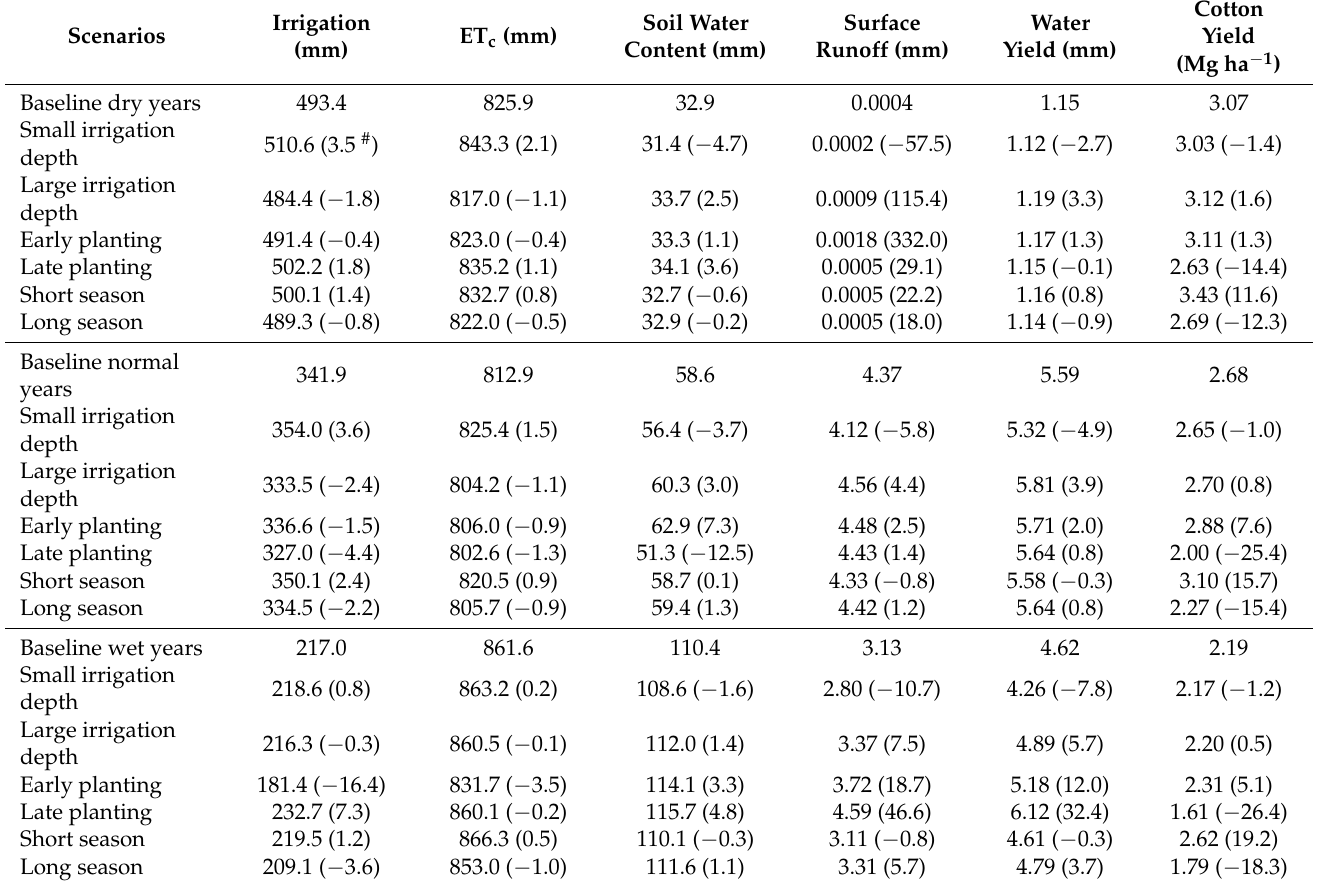
Table 4. Comparison of the average annual water balance parameters and cotton yield under three hydroclimatic regimes using different irrigation application depths, planting dates, and maturity cultivars in the irrigated cotton HRUs in the Double Mountain Fork Brazos